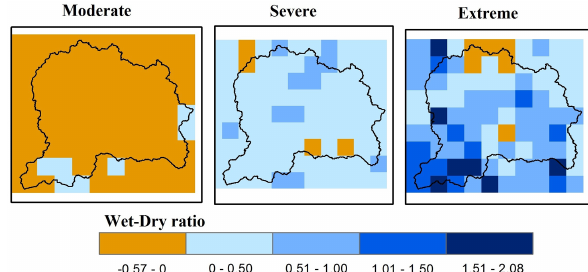
Figure 7. Spatial distribution of wet–dry (WD) ratio derived for three levels of severity (moderate, severe, and extreme) during the period 1981–2014. Blue (WD ratio > 0) means that the area expe- rienced more wet than dry events. Brown (WD ratio < 0) indicates the